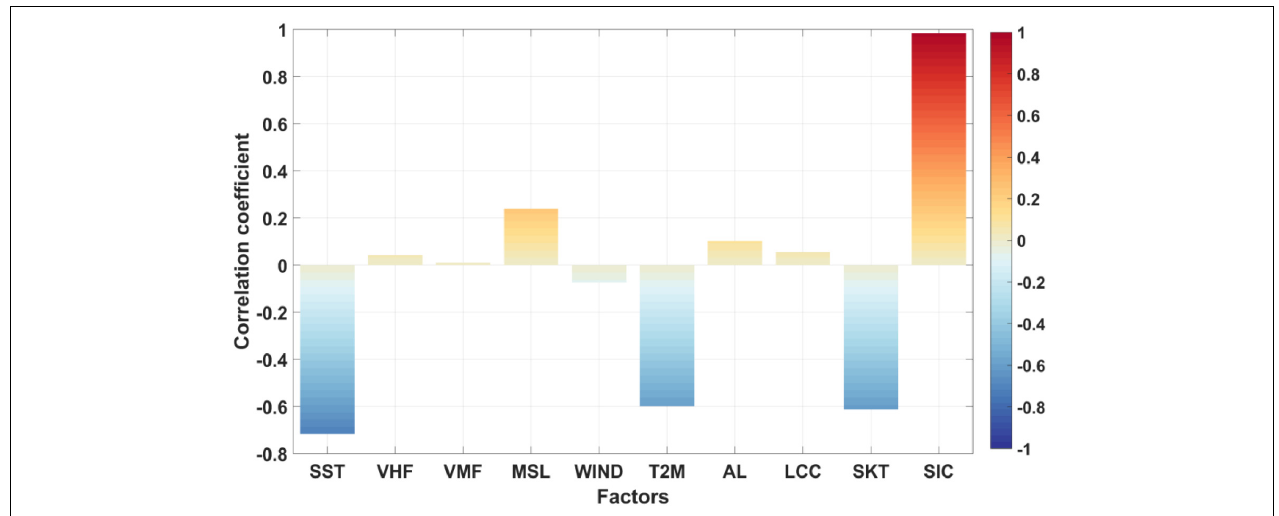
FIGURE 1 | Time lag correlation coefficient of each factor. The intensity of warmer and cooler colors represents the magnitude of the time lag